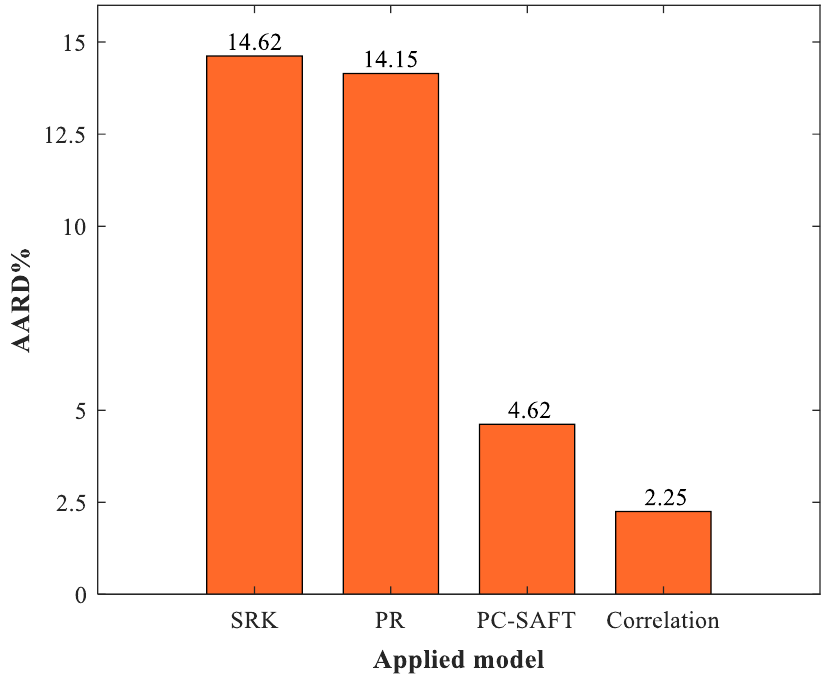
Figure 4. Accuracy of the predicted H 2 solubility in furfuryl alcohol by the Arrhenius type correlation and equations of state [29].